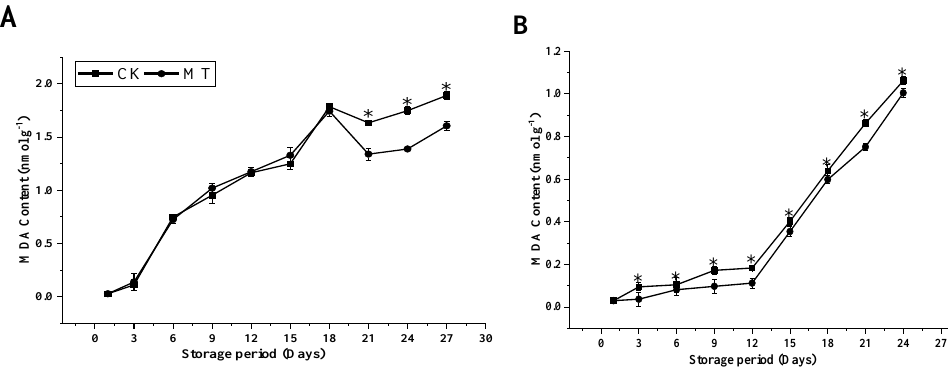
Figure 6. MDA content ( A , B ) of ‘Guiqi’ ( A ) and ‘ Tainong 1 ’ ( B ) fruits treated with 1000 μmol L −1 MT. Each value is the mean for three replicates, and vertical bars indicate the standard error (SE). Error bars with an asterisk (*) on the same storage period show a significant difference between the treatments ( p < 0.05).